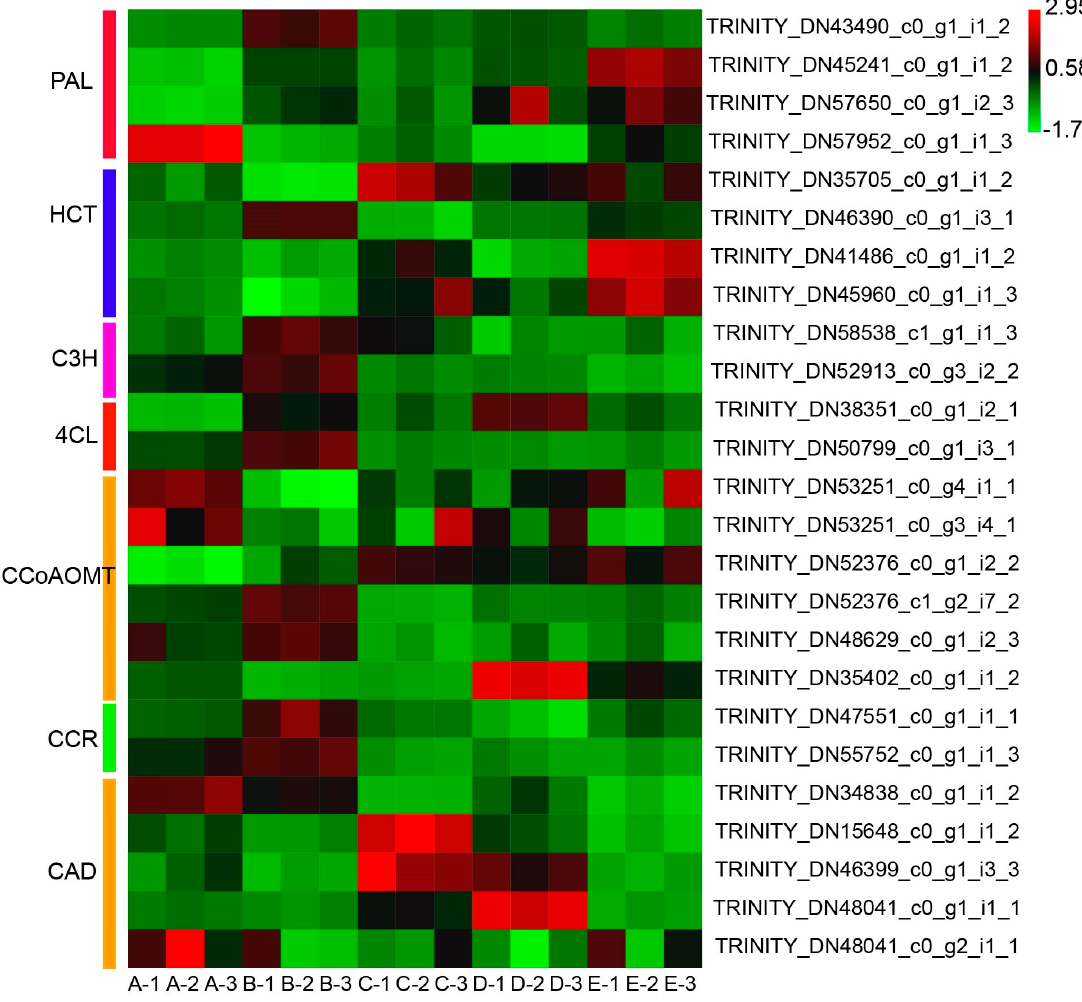
Figure 9. Expression levels of candidate genes associated with phenylpropanoid biosynthesis. PAL: